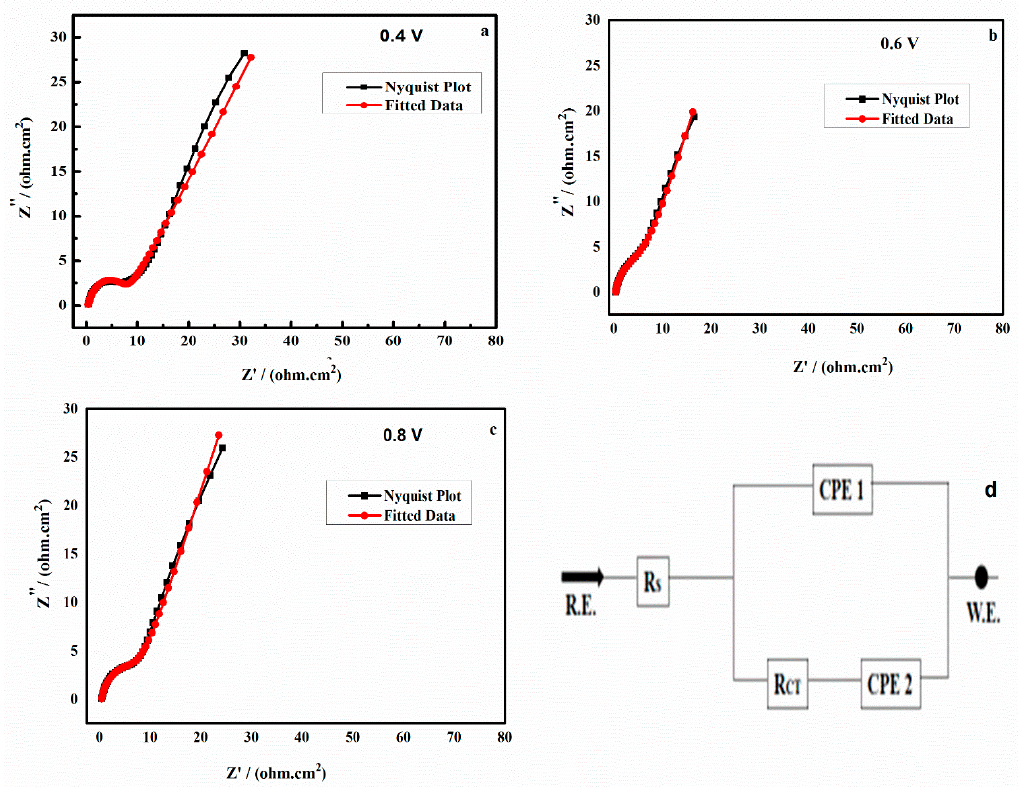
Figure 7. Impedance spectra of P-5PA ( a ) at 0.4 V, ( b ) 0.6 V, ( c ) 0.8V and ( d ) proposed equivalent circuit for P-5PA film. Table 6. Parameters derived from impedance spectra of P-5PA at different voltages.